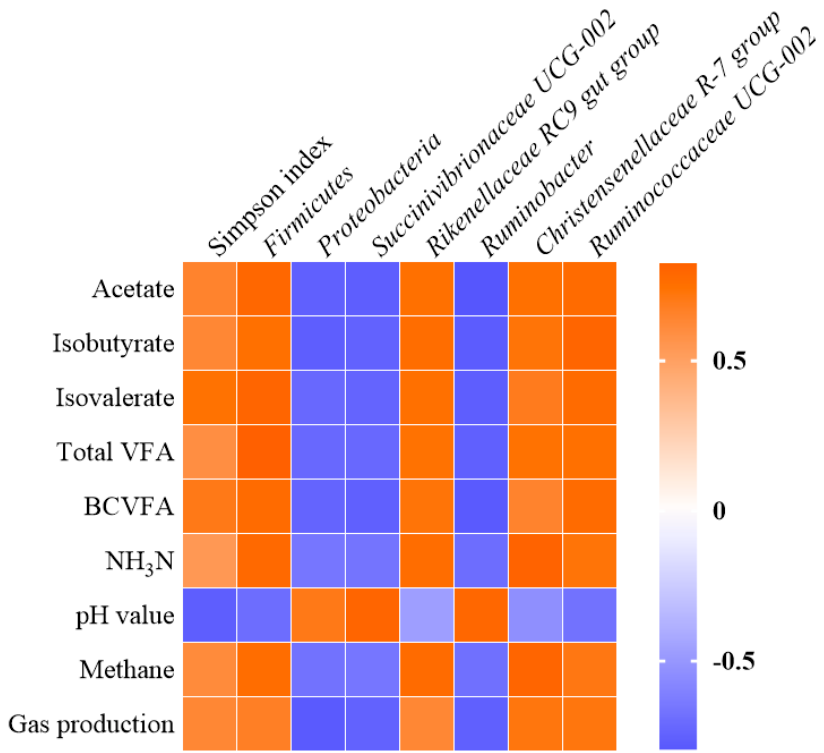
Figure 4. Correlations between gas production, rumen fermentation characteristics, and rumen bacterial community. VFA, volatile fatty acids; BCVFA, branched-chain volatile fatty acids; NH 3 -N, ammonia nitrogen; only significant correlations (r > 0.70 or r < − 0.70 and q < 0.05) and bacteria with average relative abundances > 0.5% are shown. The colors indicate positive (red, closer to 1) or negative (blue, closer to − 1).